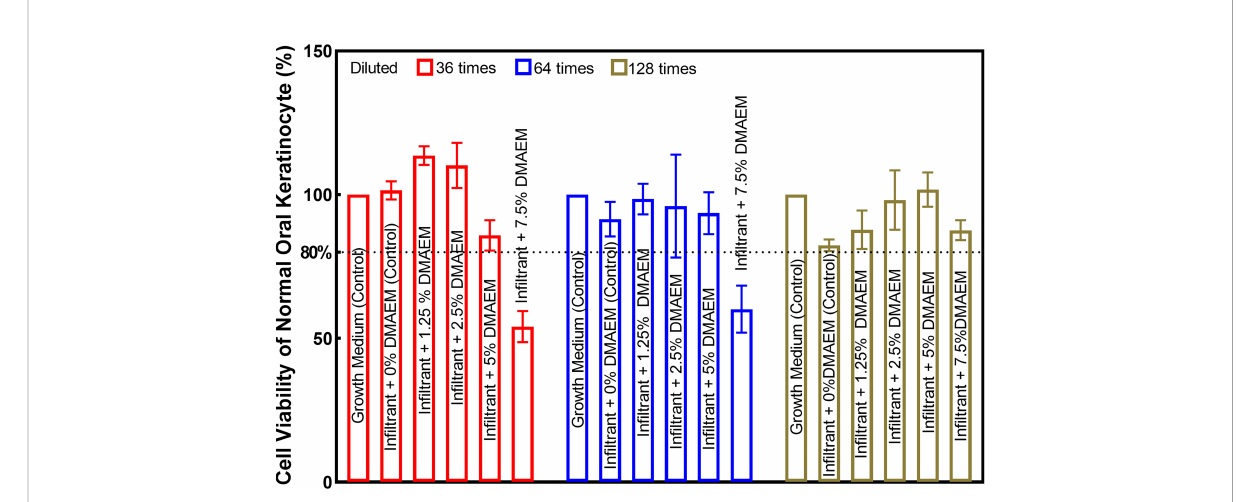
FIGURE 2 Cell viability of normal oral keratinocyte was used to test the biocompability of DMAEM resin in fi ltrant. The viability was acceptable when that was not less than 80% of the control group according to ISO 10993-5-2016